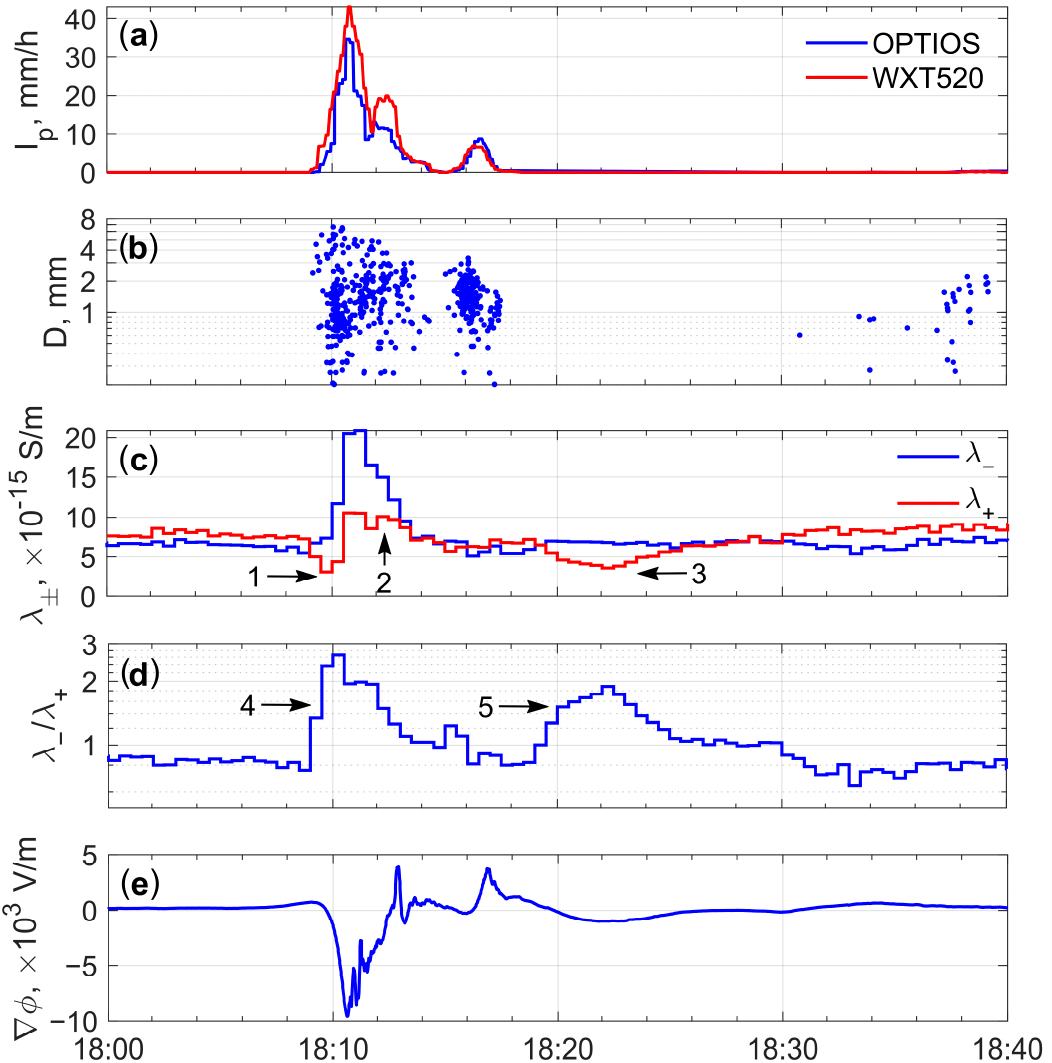
Figure 3. Pattern of atmospheric electric values and frontal precipitation characteristics on 17 June 2019. The plots (from up to down) show the variation of precipitation intensity I p ( a ), droplet density written in time–droplet diameter coordinates D ( b ), electroconductivity λ − , λ + ( c ), electroconductivity ratio λ − / λ + ( d ) and potential gradient ( ∇ ϕ ), recalculated based on the conversion factor ( e ). Here is shown a local time.